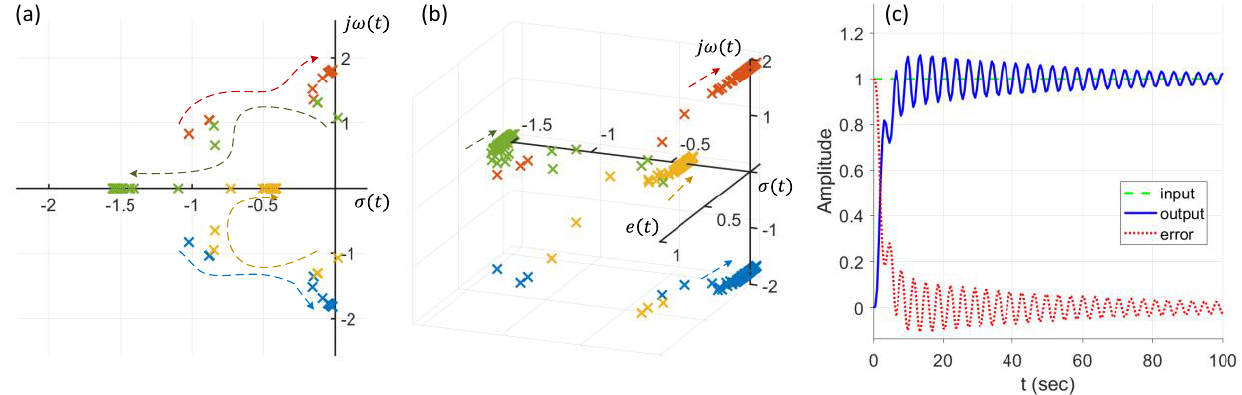
Figure 8. Dynamic pole motion of the controlled hybrid soft leg and the controlled system response by error change with the gains of K pf = 1.1, K vf = 3.5, α = 1, and β = 2: ( a ) 2D plot, ( b ) 3D plot, and ( c ) the system response to the step input. The arrows indicate the direction of pole motions.